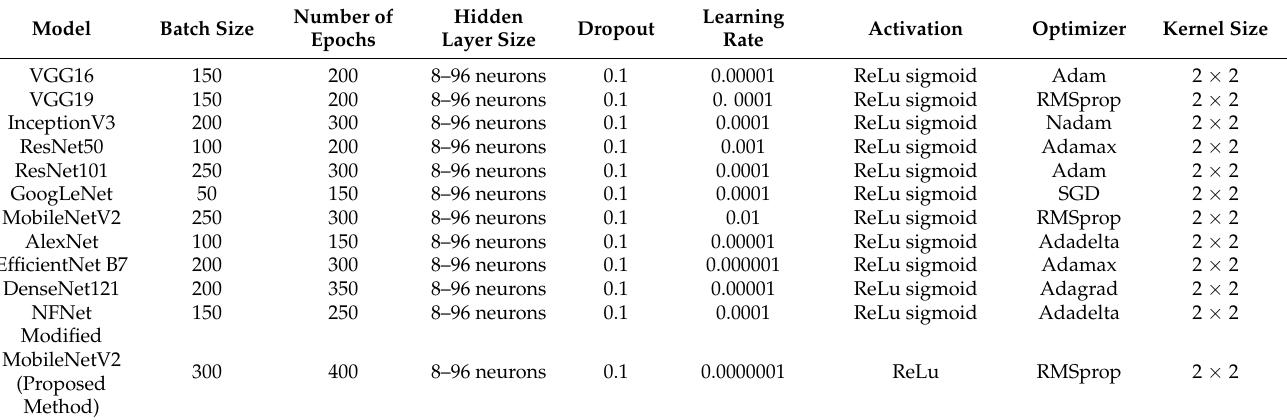
Table 5. Model final